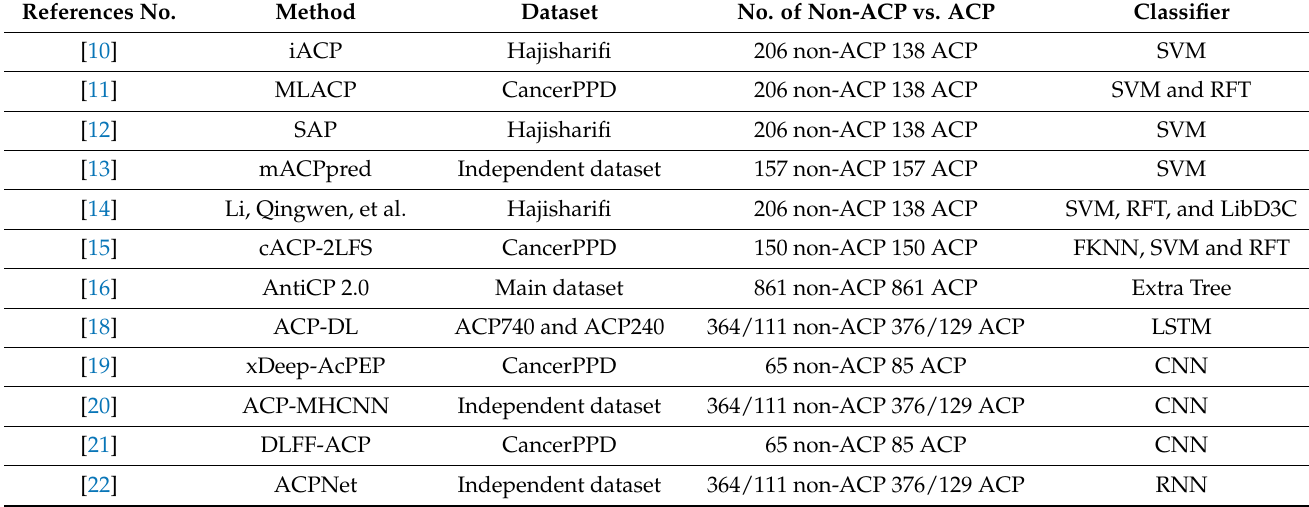
Table 1. Summary of the related